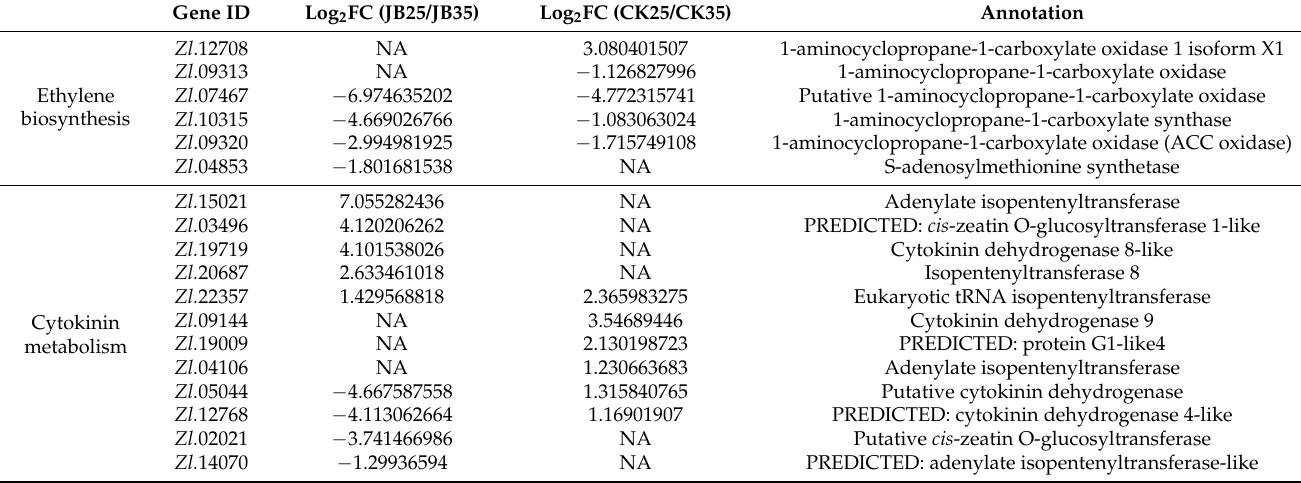
Table 2. Differentially expressed genes involved in ethylene biosynthesis and cytokinin metabolism in Zizania latifolia between Z. latifolia infected with Ustilago esculenta grown at 25 ◦ C (JB25) and 35 ◦ C (JB35), as well as Z. latifolia plants without U. esculenta infection grown at 25 ◦ C (CK25) and 35 ◦ C (CK35) †